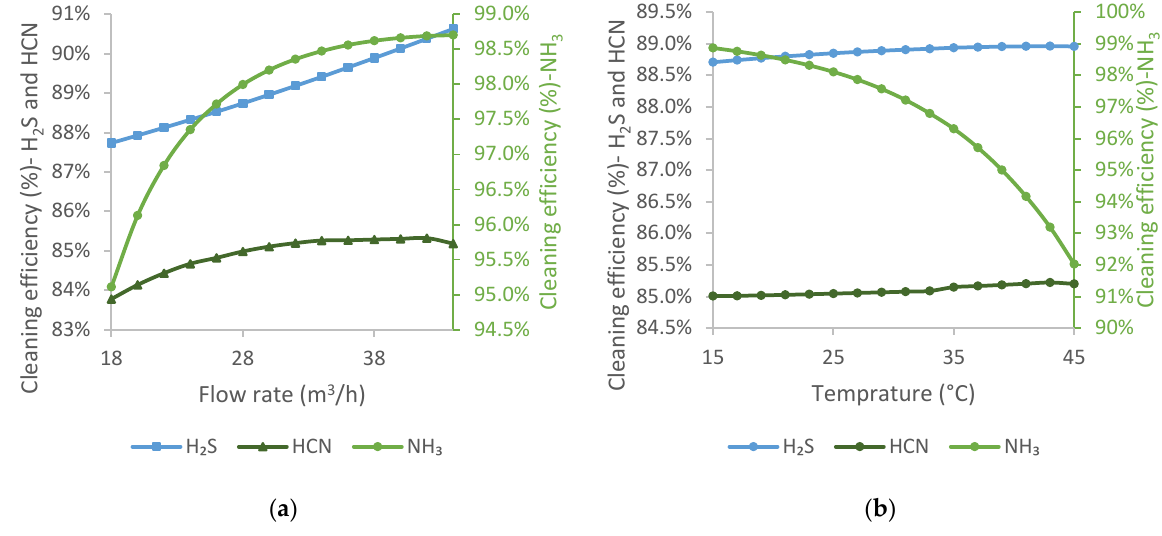
Figure 6. Effect of flow rate ( a ) and temperature ( b ) of coal water.